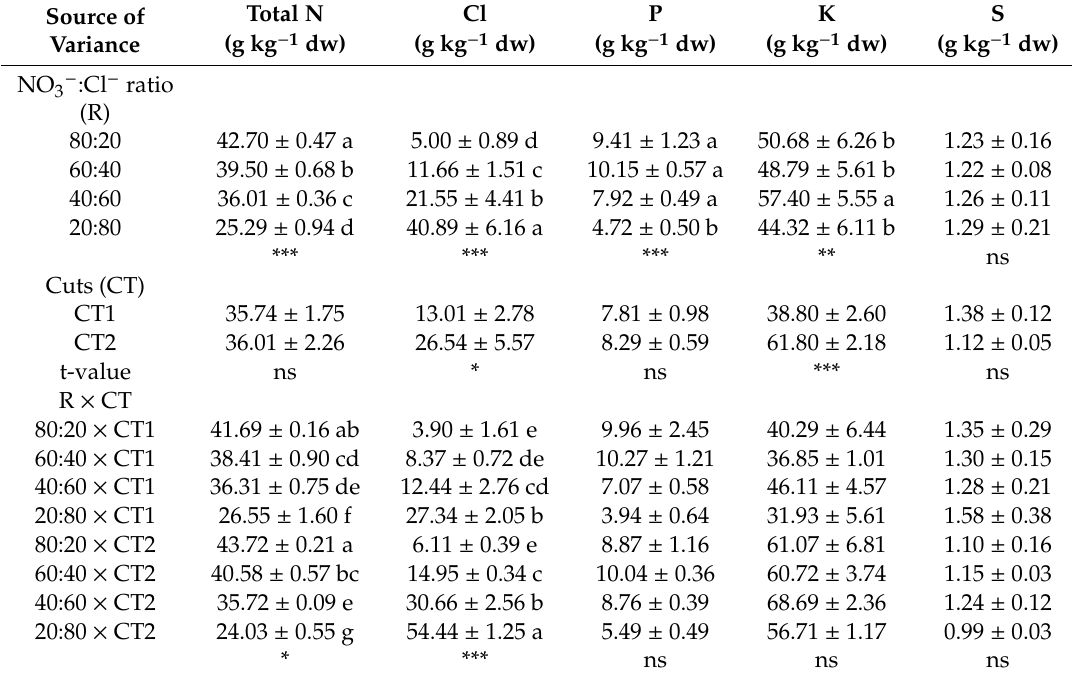
Table 3. Analysis of variance and mean comparisons for mineral composition of greenhouse basil cultivated under four NO 3 − :Cl − ratios (R) in the nutrient solution and harvested in two successive cuts (CT). Source